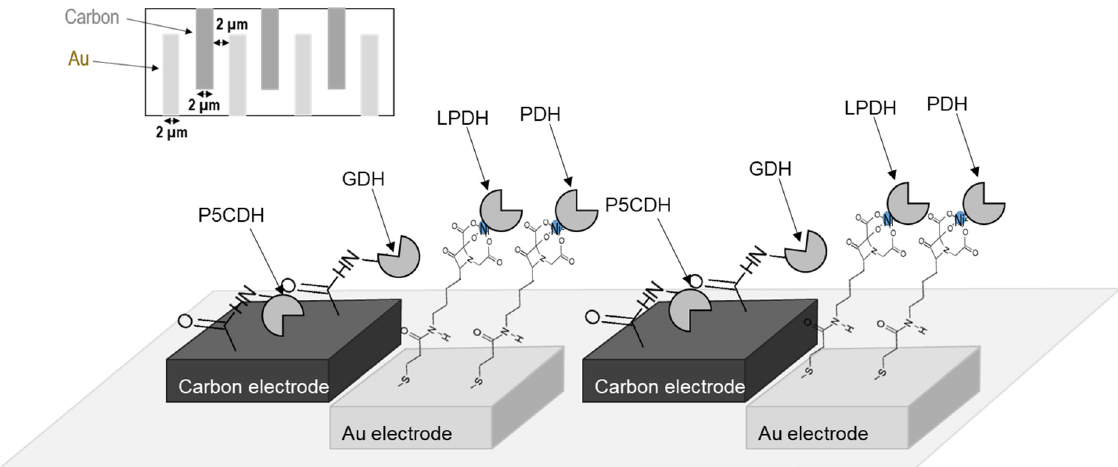
Figure 3. Illustration of the arrangement of enzymes on the microfluidic system electrodes in this study. The upper left figure shows the detailed structure of the comb electrodes of the second and third electrodes.